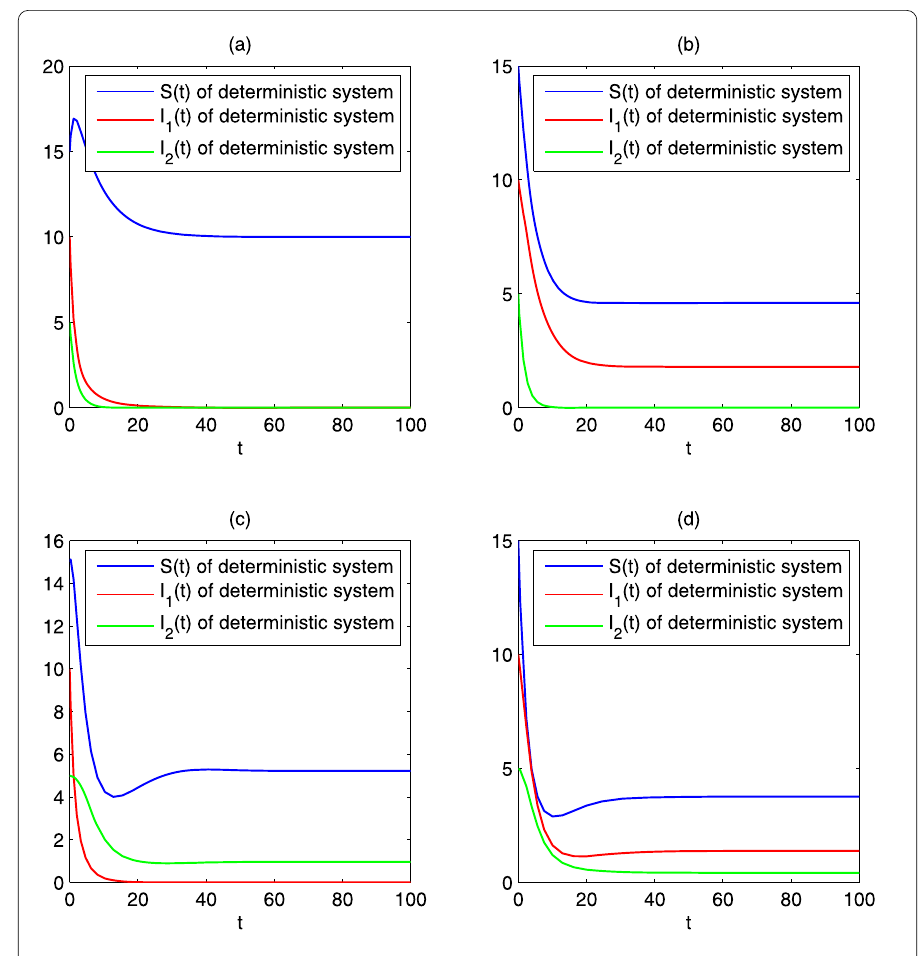
Figure 1 Time evolutions of the deterministic SIS system with parameters A = 1, d = 0.1, β 1 = 1.2, β 2 = 1.5, a 1 = 1, a 2 = 1.5, b 1 = 2, b 2 = 1, α 1 = 0.2, α 2 = 0.4. (a) Time series for S ( t ), I 1 ( t ), I 2 ( t ) with parameters r 1 = 0.9, r 2 = 0.9, R 1 = 0.9091, R 2 = 0.6696. (b) Time series for S ( t ), I 1 ( t ), I 2 ( t ) with parameters r 1 = 0.3, r 2 = 0.9, R 1 = 1.8182, R 2 = 0.6696. (c) Time series for S ( t ), I 1 ( t ), I 2 ( t ) with parameters r 1 = 0.9, r 2 = 0.3, R 1 = 0.9091, R 2 = 1.1719. (d) Time series for S ( t ), I 1 ( t ), I 2 ( t ) with parameters r 1 = 0.3, r 2 = 0.3, R 1 = 1.8182, R 2 =